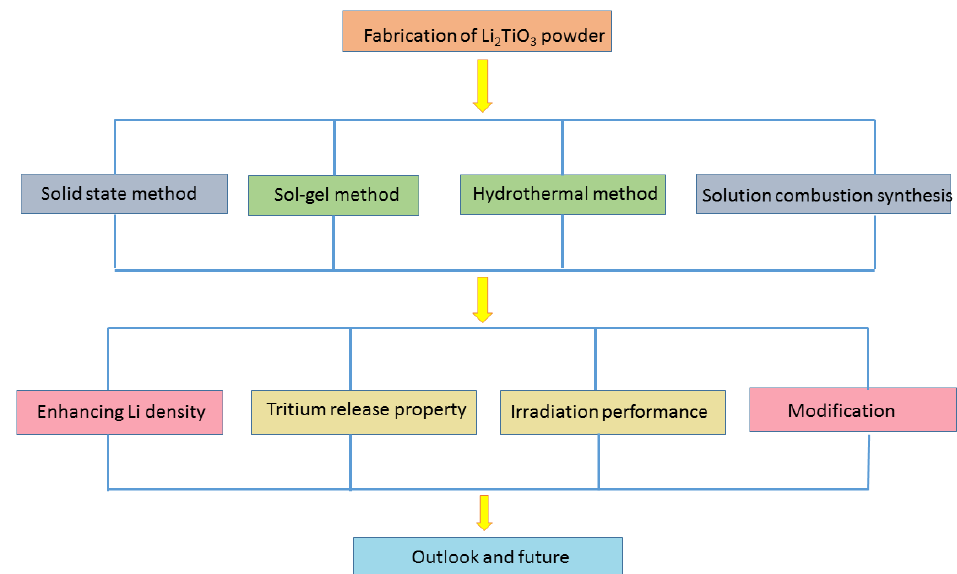
Figure 1. The structure of the review including the fabrication of Li 2 TiO 3 power and tritium breeding characteristics. Table 1. The comparison of characteristics of the solid tritium breeder candidates. Ceramic Breeder Li Density (g/cm 3